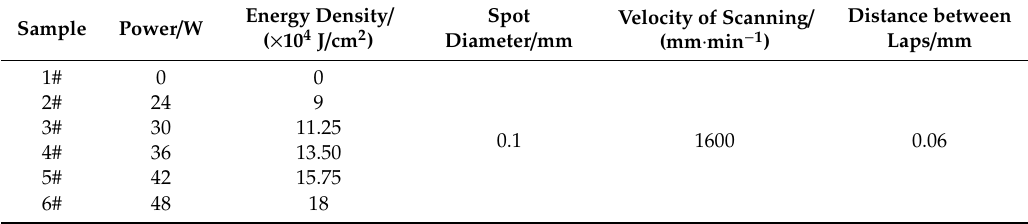
Figure 1. Temperature field simulation analysis model of Cr coating laser melting treatment. Table 3. Process parameters of Cr coating laser melting.